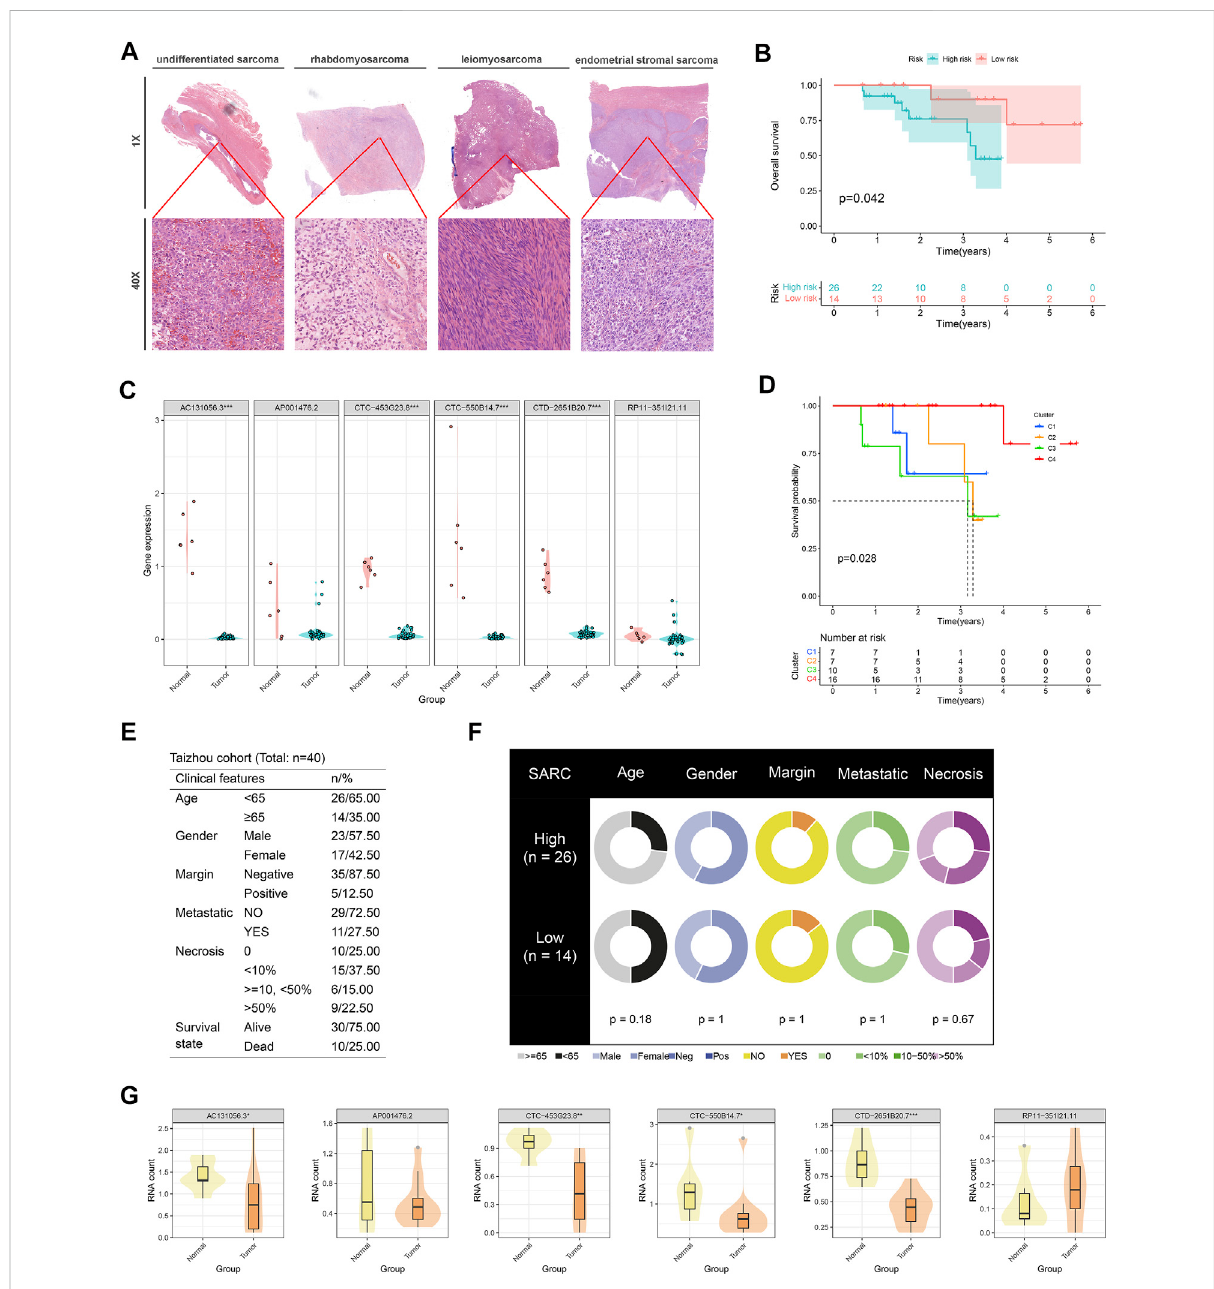
FIGURE 8 Independent queue validation of the CuLncScore model and cuproptosis lncRNA classi fi cation. (A) Representative images of the pathological HE staining of the Taizhou cohort. (B) Overall survival differences between high and low-risk groups in the Taizhou cohort. (C) Some sensible cuproptosislncRNAswereidenti fi edbytheRT-PCRintheTaizhoucohort. (D) OverallsurvivaldifferencesbetweenfourcuproptosislncRNAclusters in the Taizhou cohort. (E) Table of clinicopathological characteristics of the Taizhou cohort. (F) Clinicopathological features of the distinct risk groups. (G) The expression distribution of cuproptosis lncRNAs in normal and tumor tissues was checked by transcriptome sequencing. * p < .05, ** p < .01, *** p <